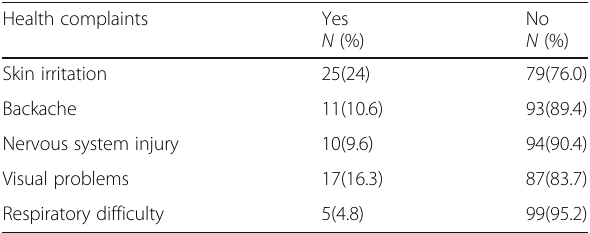
Table 4 Work-related health complaints as reported by participants, Cameroon, 2017 ( N = 104)